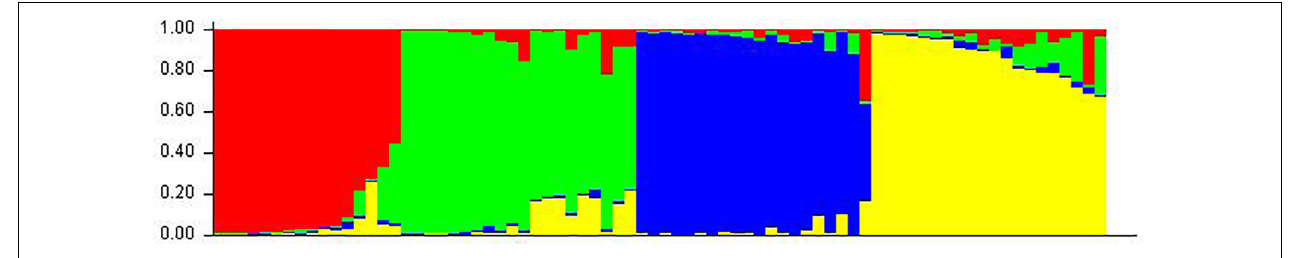
FIGURE 12 | Classification of 76 sesame accessions into four populations ( K = 4) using STRUCTURE v2.3.4. Each accession is represented by a single row, which is partitioned into colored segments (P1 = Red, P2 = Green, P3 = Blue, and P4 = Yellow) in proportion to the estimated membership in the four